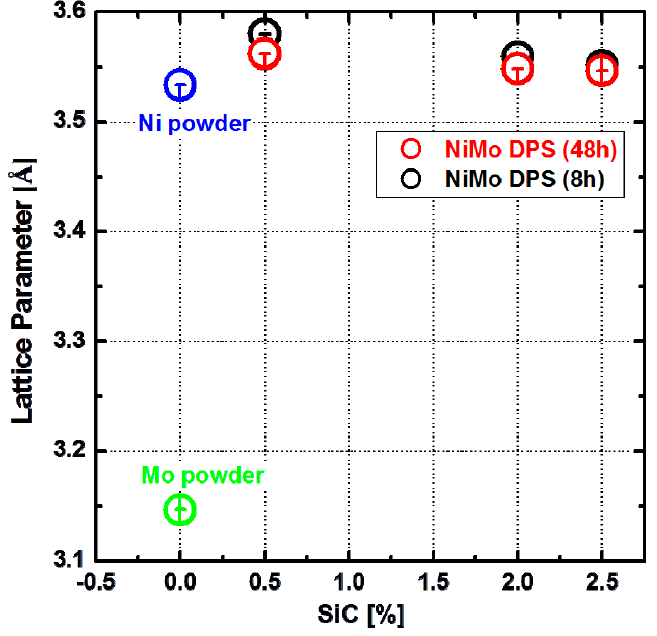
Figure 6. Lattice parameters of Ni and Mo in as-milled condition, as well as Ni-Mo matrix in bulk 48-h-milled and 8-h-milled NiMo-SiC DPS alloys with an increasing amount of SiC in the initial powder mixture